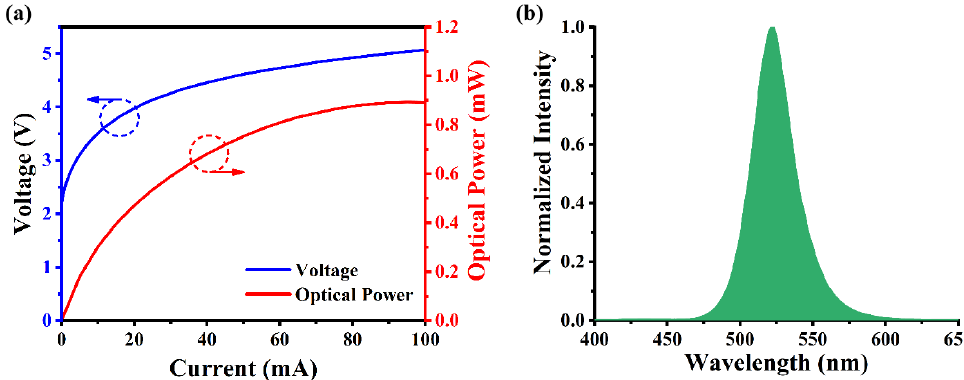
Figure 5. ( a ) The I-V and L-I characteristics of the InGaN-based Micro-LED, ( b ) electroluminescence spectra of the InGaN-based Micro-LED.